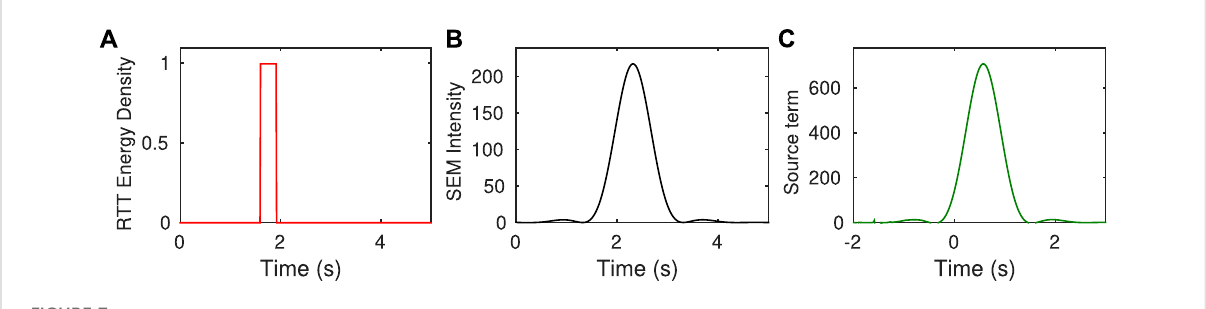
FIGURE 7 Identi fi cation of the source term in the radiative transfer equation. At a distance z = 5 km from the source in a non-scattering medium, the energy density predicted by RTT (A) is deconvolved from the intensity computed by SEM simulations (B) to obtain the source time function (C) This example corresponds to the frequency band [1 , 2]